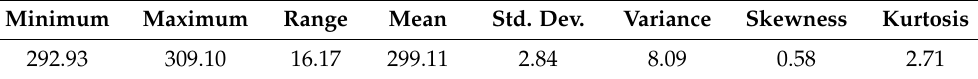
Table A5. Statistics of the averaged air outlet temperature distribution [K]. Minimum Maximum Range Mean Std.